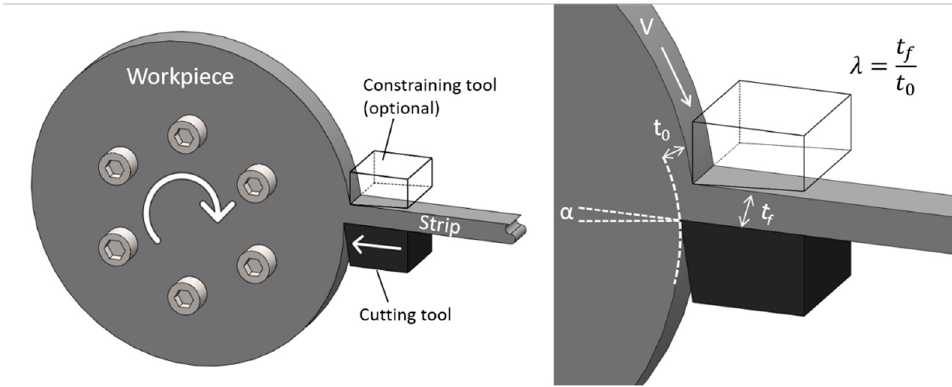
Figure 1. Schematic of the LSM process used to manufacture samples A&B.